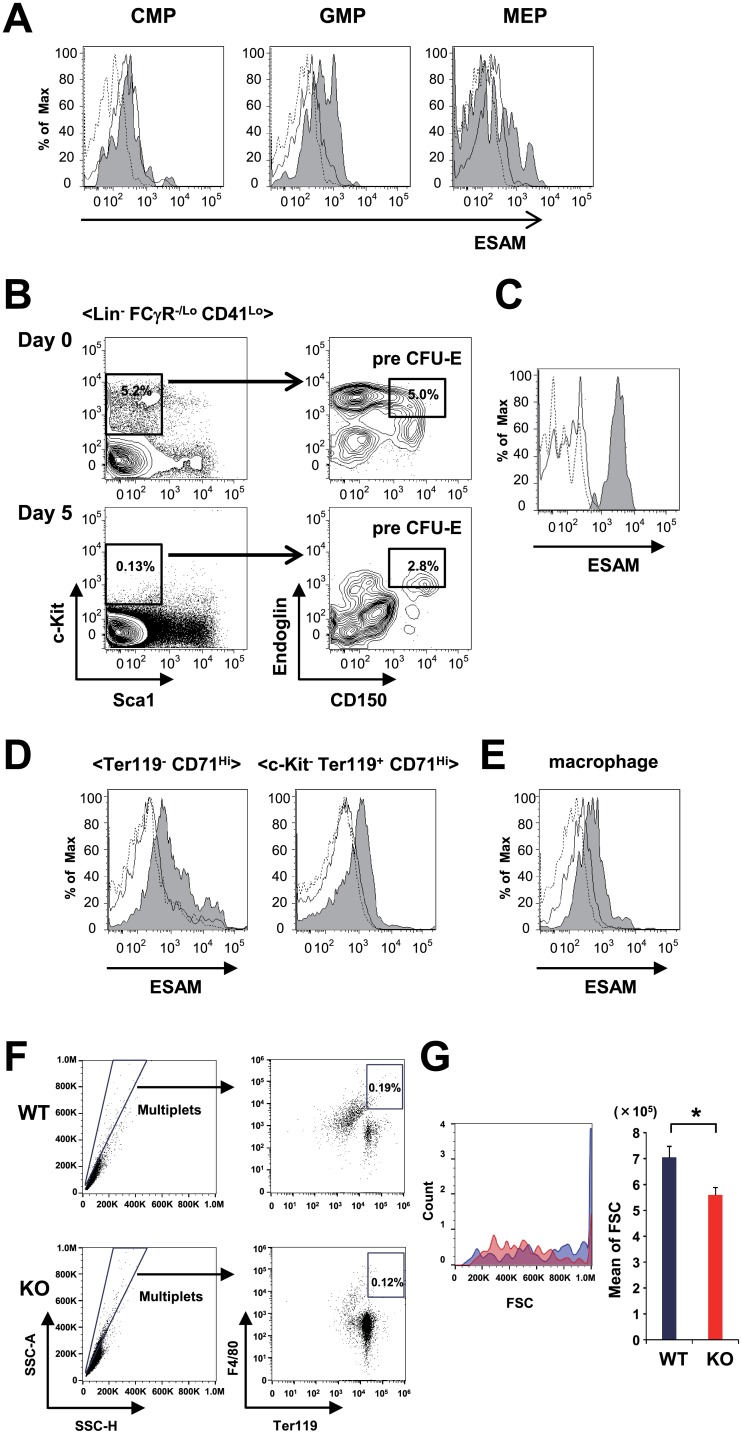
ESAM is up-regulated after 5-FU treatment in erythroid progenitors and macrophages.(A-E) C57BL/6J WT mice were treated with a single intravenous 5-FU (150 mg/kg) injection, and ESAM expression levels in myeloid or erythroid progenitors and macrophages in the BM were evaluated by FACS. In each histogram, the solid line and tinted line show ESAM levels after 5-FU treatment at day 0 (control) and day 5, respectively. The background level is added to each panel with an isotype control Ab (dashed line). (A) ESAM expression levels of CMP, GMP, and MEP fractions are shown. (B) Representative FACS profiles of pre CFU-E cells in BM after 5-FU treatment at day 0 and day 5 are shown. (C) ESAM expression levels in the pre CFU-E fraction are shown. (D) ESAM expression levels in the Ter119- CD71Hi fraction and the c-Kit- Ter119+ CD71Hi fraction are shown. (E) ESAM expression levels of Gr1- F4/80+ CD115Int SSCInt/Lo macrophages are shown. (F) Representative FACS profiles of BM cells from 5-FU-treated WT and ESAM-KO mice (150 mg/kg) at day 8 are shown. Each number indicates the percentage of F4/80+ Ter119+ multiplets (erythroblastic islands). (G) In the left histogram, cell sizes determined by FSC in the erythroblastic island population of WT (blue) and ESAM-KO (red) mice are shown. In the right graph, the actual value of FSC is shown. Data are shown as mean ± SEM. Statistically significant differences are represented by an asterisk (*P < 0.05).